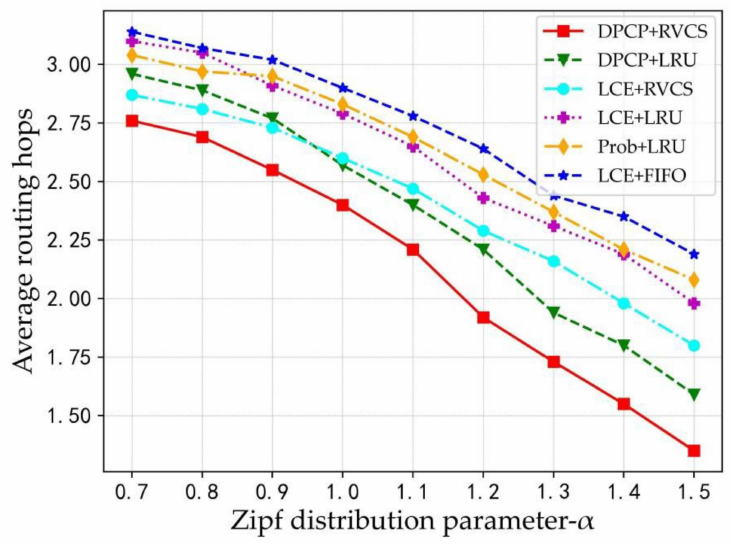
Figure 5. The influence of Zipf distribution parameter on the average routing